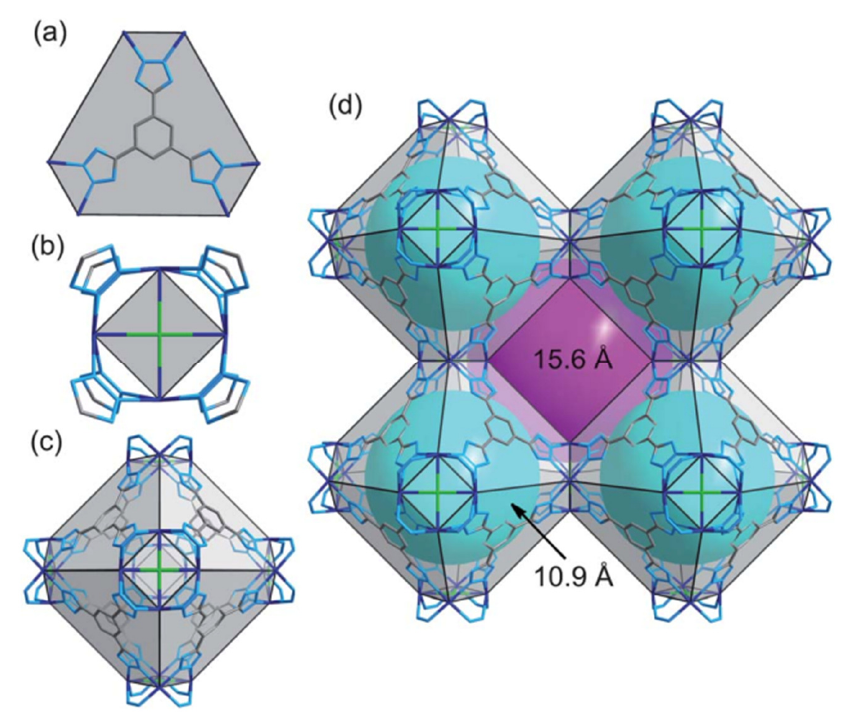
Figure 9. Views of the frameworks of 1 and 2 in wire representation (color codes: N, light blue; Co or Cd, dark blue; C, grey, Cl, green). ( a ) BTT ligand connected with six neighboring M 2+ ions constructing the 3-connected node and hexagonal face. ( b ) Four M 2+ ions bridged by eight tetrazolate rings forming the 8-connected node and square face. ( c ) A sodalite-like cage constructed from six [M 4 Cl] 7+ units and eight BTT linkers located at its square and hexagonal faces, respectively. ( d ) A cube of eight cages, each of which is connected with six adjacent cages through its square faces. The void cavity inside the cages and the one formed by connecting eight such cages are displayed as cyan and magenta spheres, respectively. For clarity, hydrogen atoms and coordinated water molecules have been removed from all structural plots [95].